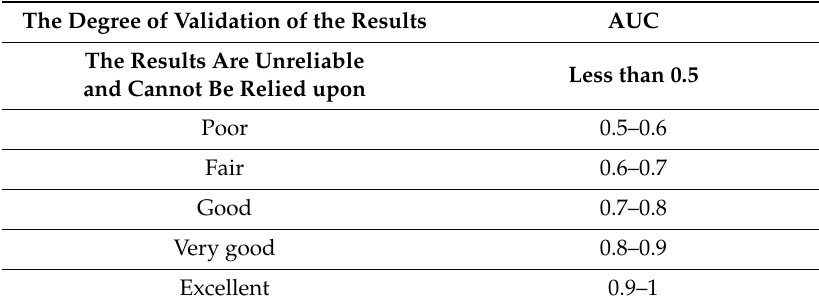
Table 22. Area under the curve (AUC) values and the degree of validation of the results.